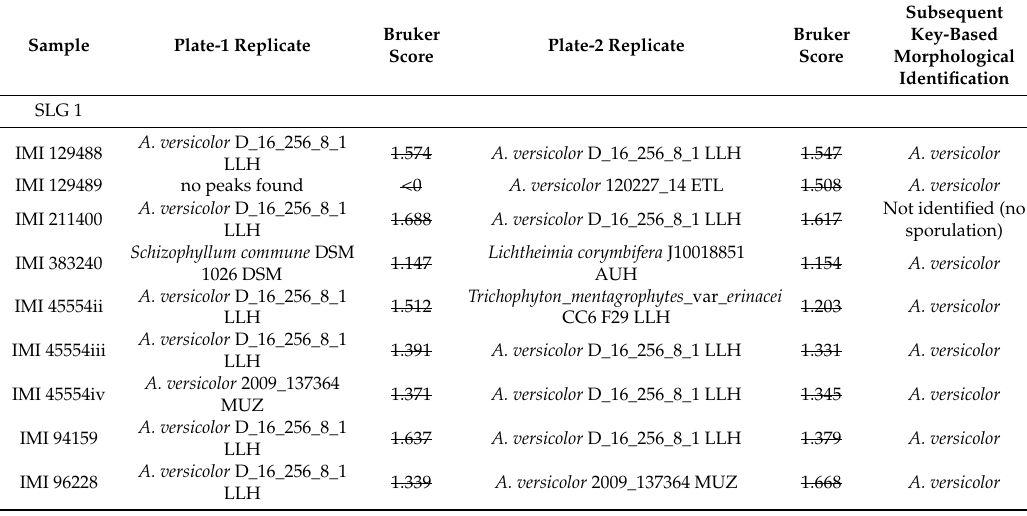
Table 3. Bruker scores for spectral comparison against the Bruker database of filamentous-fungal samples for the SLGs and SUSs, along with taxonomic-key-based identification results.